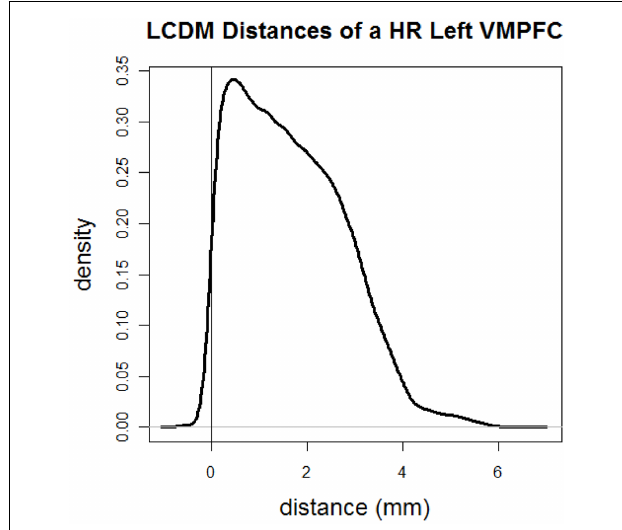
FIGURE 2 | Kernel density estimate of directed (i.e., signed) LCDM distances of GM voxels for a sample cortical structure of interest . More specifically distances are for the GM of the leftVMPFC of a HR